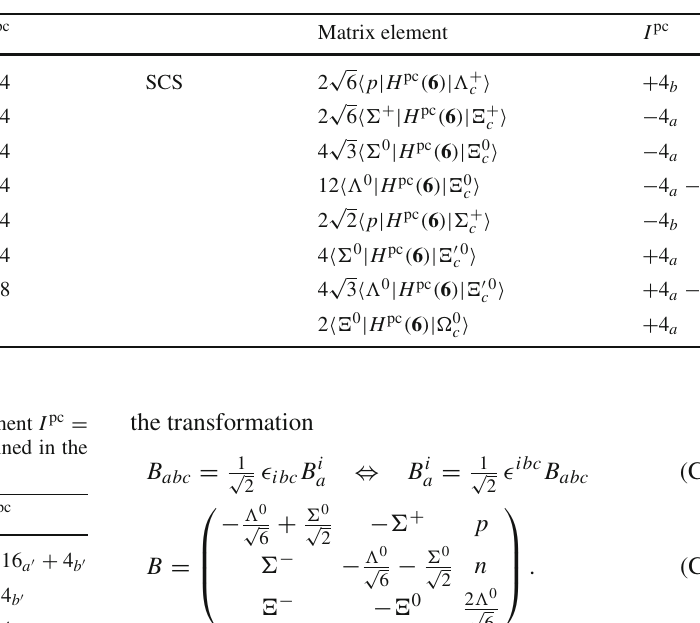
Table 15 (cid:2) C = 1 values of the weak transition matrix element I pc = (cid:4) B f | H pc ( 6 ) | B i (cid:5) . The suffix labelling ( a ) and ( b ) for the SCS decays is explained in the caption of Table 8